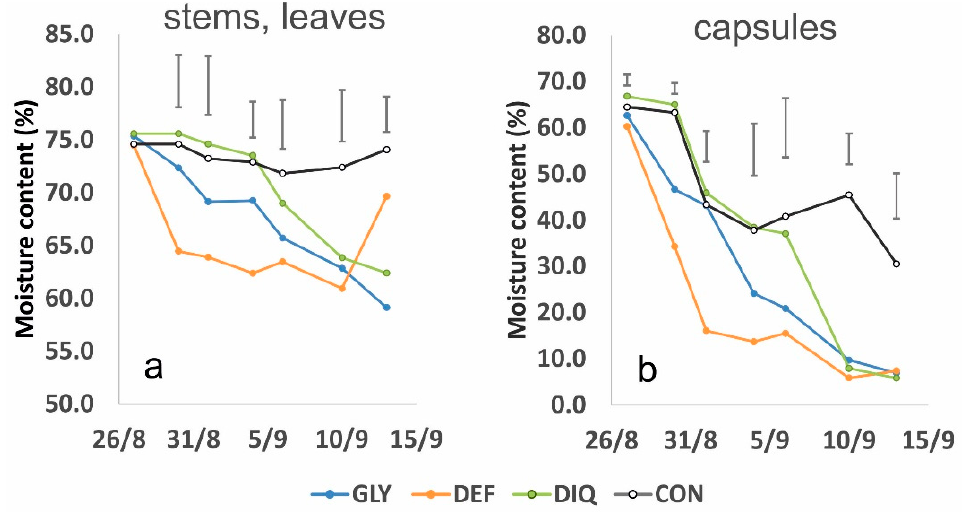
Figure 5. Changes in moisture content in ( a ) vegetative (stems and leaves) and ( b ) reproductive (capsules) plant parts after applying the harvest aids (GLY = Glyphosate 27/8, DEF = Spotlight ® 27/8, DIQ = Diquat 4/9 and CON = Control). Vertical bars denote LSD at p = 0.05.